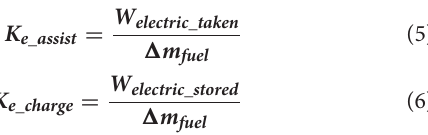
additional PN limits led to the application of DPF for all vehicles and to a huge decrease in PN